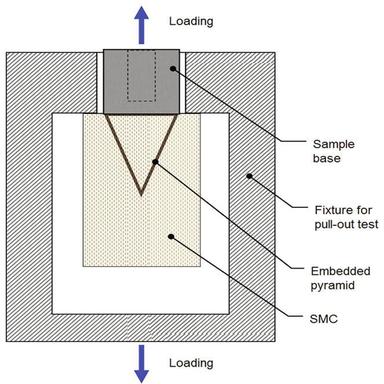
scheme of the testing fixture for pullout test and sample assembly. kling distribution about the central vertical axis.